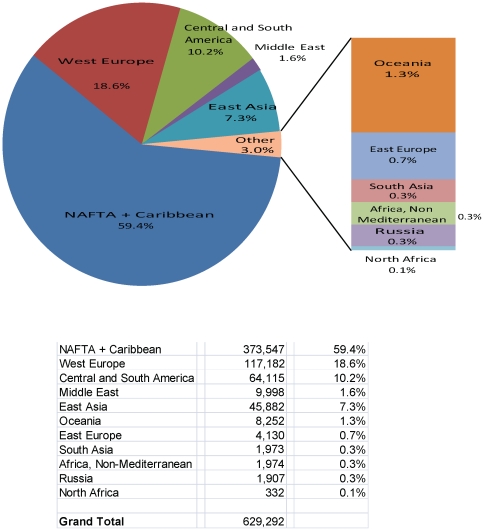
International Airline Arrivals into the United States, 2009.Source: Analysis of T-100 International Segment data, Bureau of Transportation Statistics, U.S. Department of Transportation.